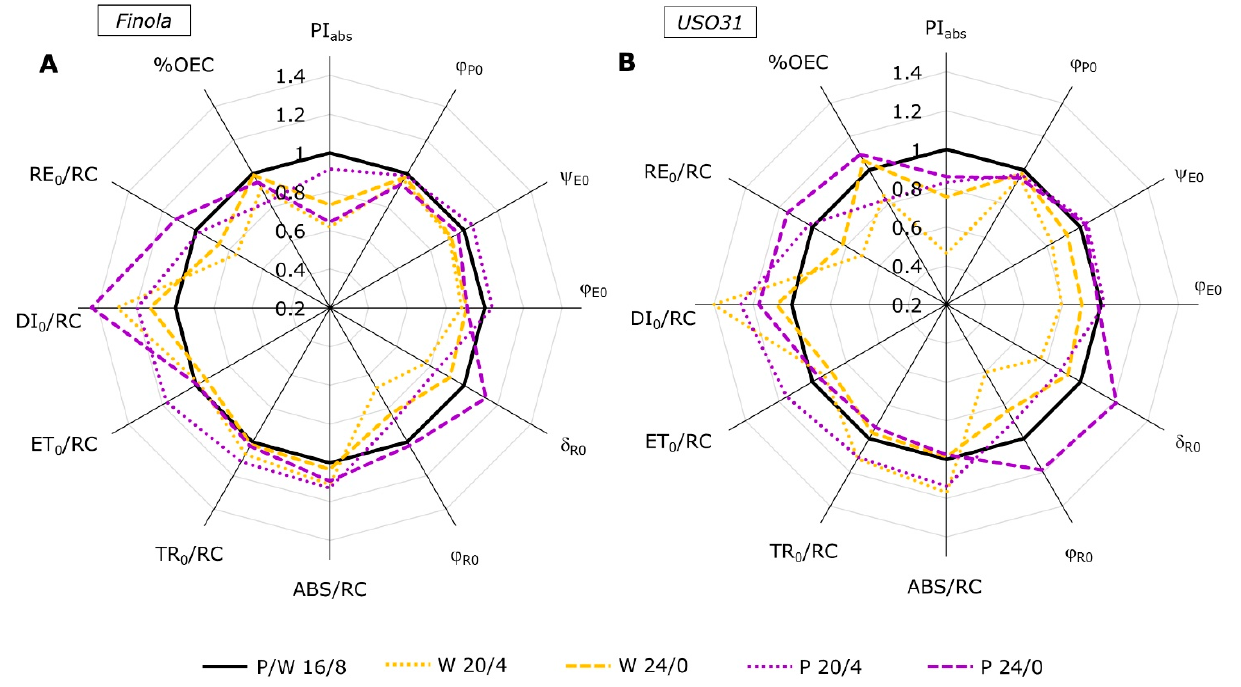
Figure 2. Radar plot of selected JIP-test parameters characterizing PSII functioning measured in Cannabis cultivars Finola ( A ) and USO31 ( B ) exposed to 16/8, 20/4, and 24/0 photoperiods and grown under white and purple light. Data are normalized to their respective controls measured at the 16/8 photoperiod for each cultivar and growth light separately (control = 1). Each curve represents mean values of 5 measurements (n = 5); LSD Finola = 0.019; LSD USO31 = 0.008.